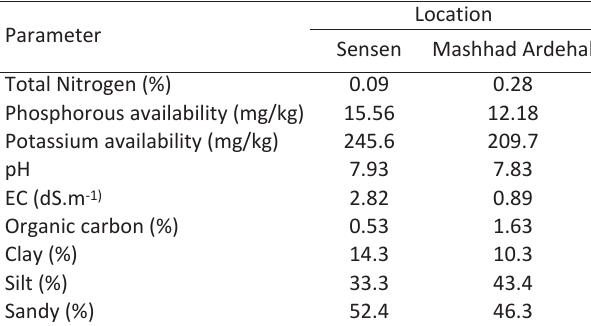
Table 1 - Weather characteristics in Mashhad Ardehal and Sensen Temperature mean (°C) Precipitation mean (mm) Humidity mean (%) Year Sensen Mashhad Ardehal Sensen Mashhad Ardehal Sensen Mashhad Ardehal 2015 Average of 5 years 20.86